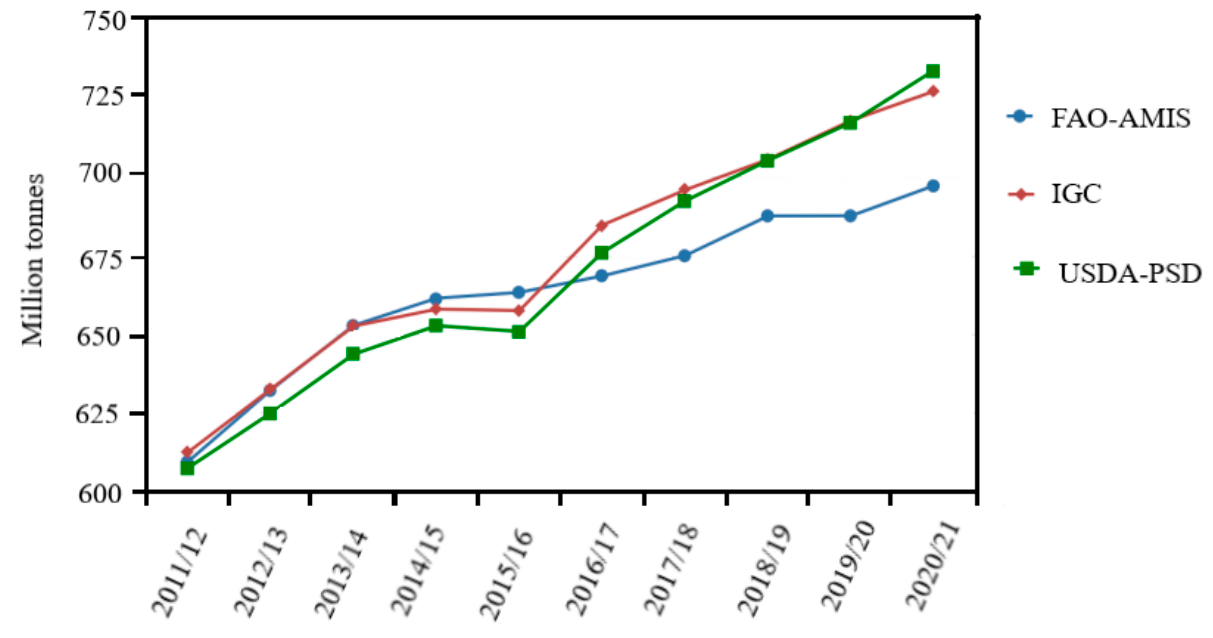
Figure 3. World rice total utilisation from 2011–2021 [7] .